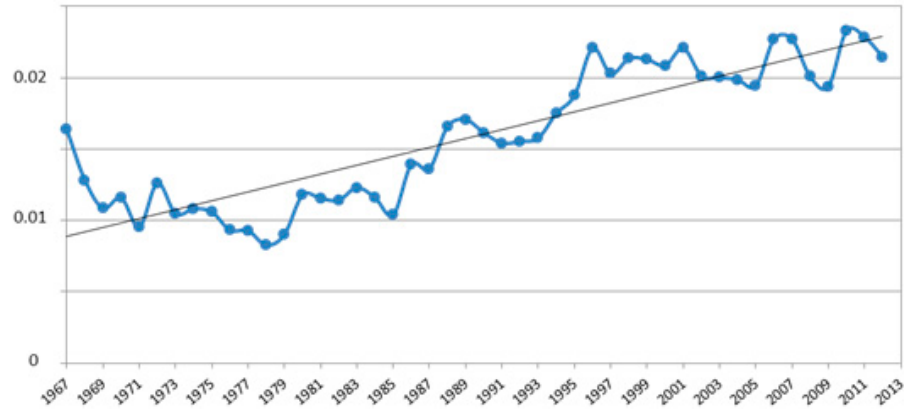
Figure 2. The average inbreeding coe ffi cient (F) by year of birth in the REF1 population.